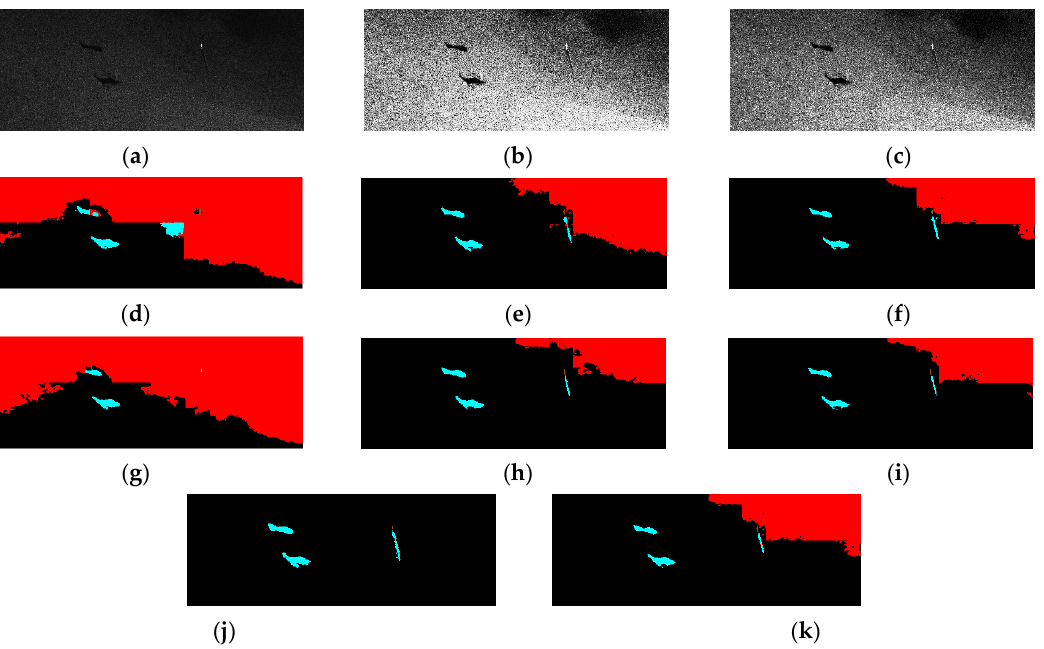
Figure 10. Example 1 of the different predictions created by the models: ( a ) original image; ( b ) image with histogram equalization; ( c ) image with contrast stretch; ( d ) DeepLabv3+ prediction; ( e ) DeepLabv3+ with histogram equalization prediction; ( f ) DeepLabv3+ with contrast stretch prediction; ( g ) Unet prediction; ( h ) Unet with histogram equalization prediction; ( i ) Unet with contrast stretch prediction; ( j ) ground truth; ( k ) ensemble model prediction.